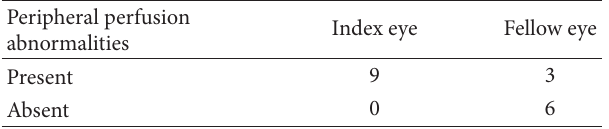
Table3:Numberoffelloweyesinpatientswithperipheralperfusion abnormalities in the index eyes showing similar